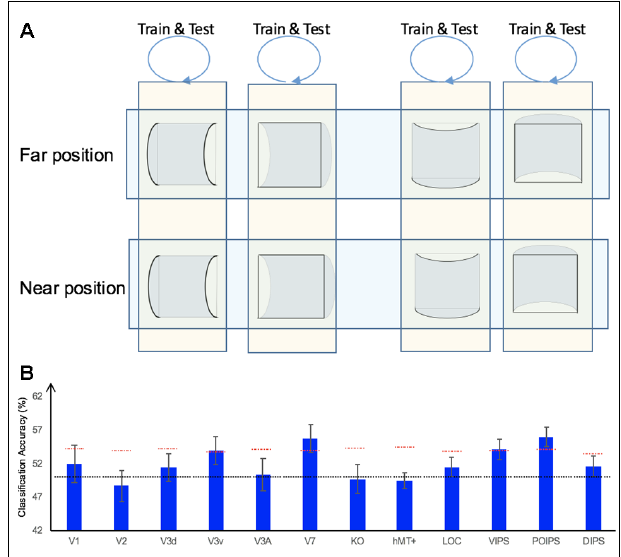
FIGURE 4 | Near–far classification and results. (A) Illustration of the near–far classification. We trained and tested support vector machine (SVM) using the same type of data. (B) The accuracy of classification for near vs. far discrimination using same-type stimuli. The red horizontal dotted lines indicate the baselines of statistical significance for ROIs. The locations of these lines indicate the upper 99.6% percentile of the distribution of the accuracy of classification of the permutated data. The black horizontal line indicates the chance level for two-class